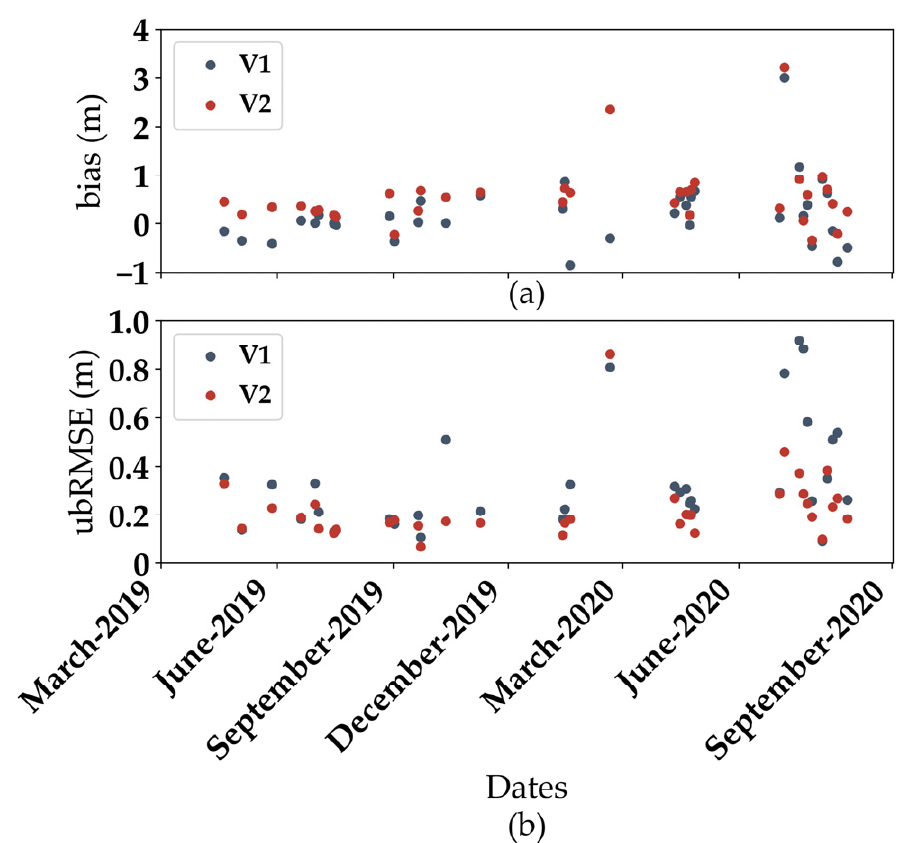
Figure 5. Mean difference between GEDI and in situ elevations of V1 and V2 product releases